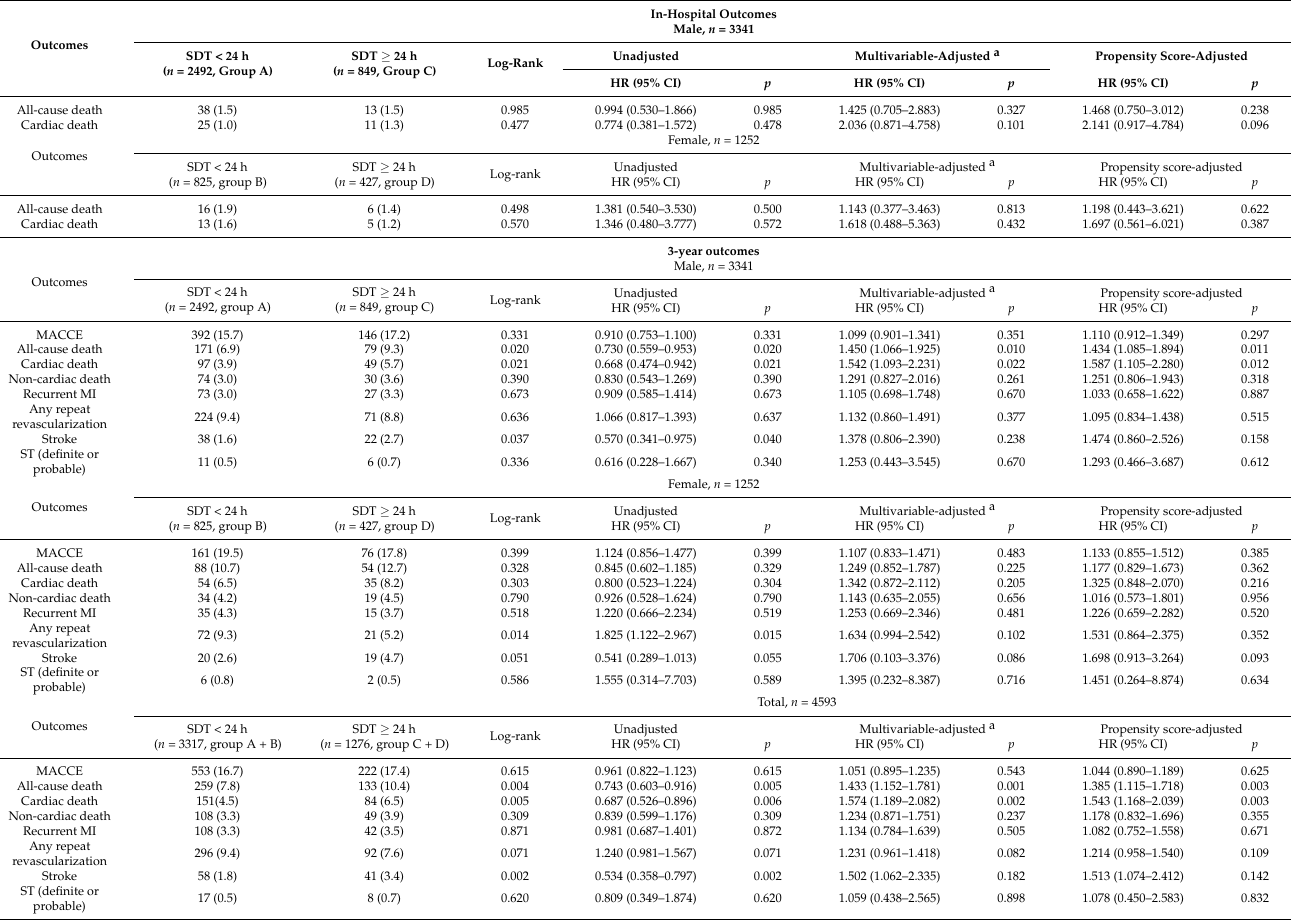
Table 3. Clinical outcomes between the SDT < 24 h and SDT ≥ 24 h groups according to sex